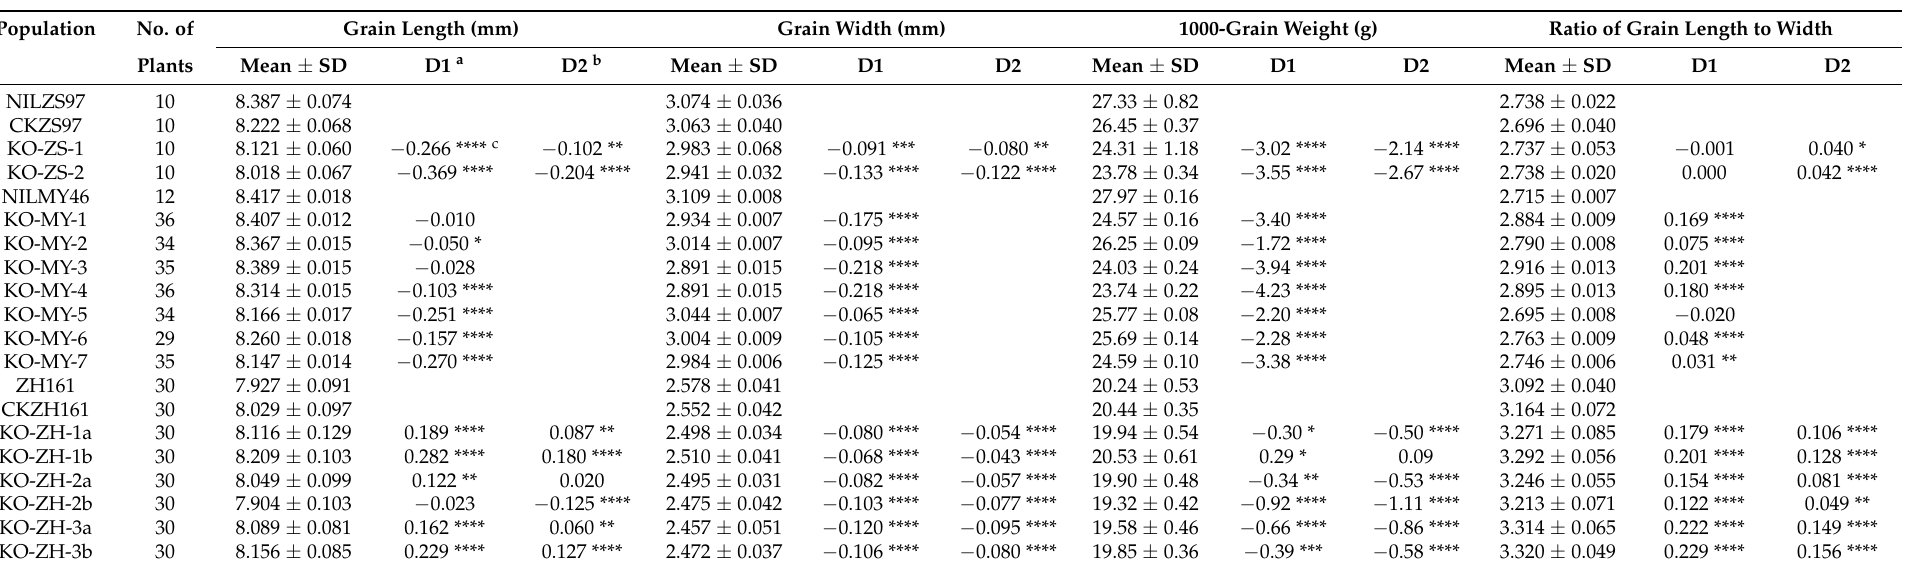
Table 1. Phenotypic change due to OsPUB3